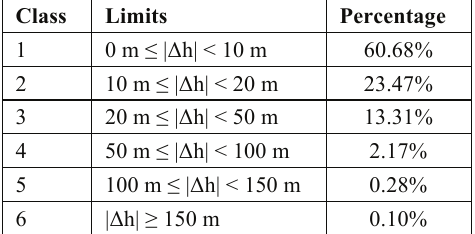
Table 1. Classes of elevation differences between Switzerland and Lombardy and their